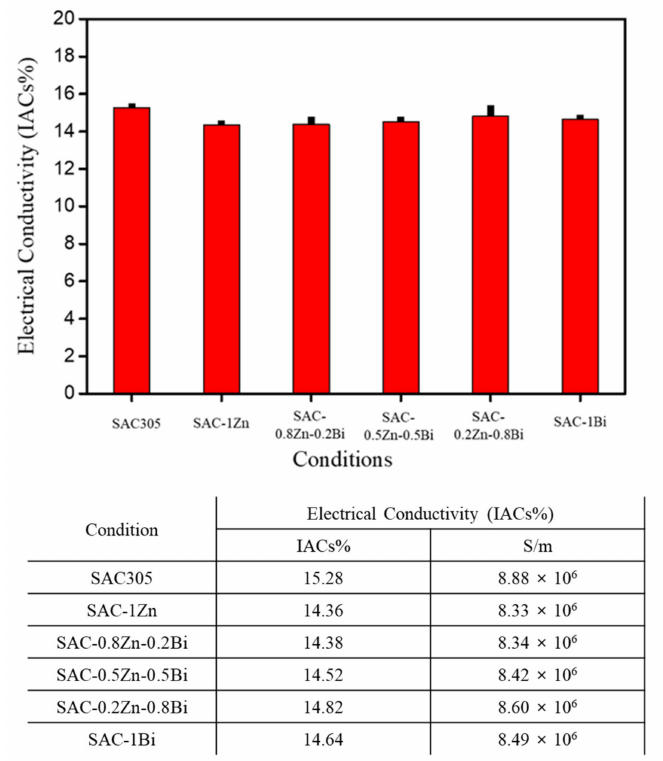
Figure 2. Electrical conductivity measurement results according to conditions.